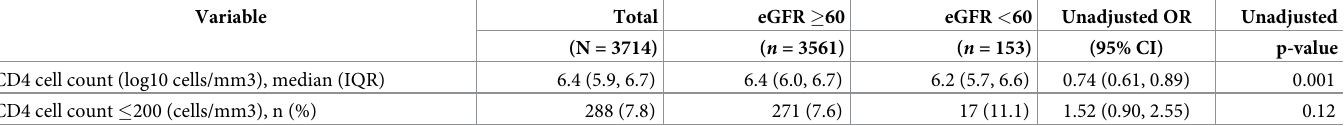
medications, emtricitabine/tenofovir was the most commonly prescribed (45%). The most common multiclass single tablet regimens were efavirenz/ emtricitabine /tenofovir (17%), elvi- tegravir/cobicistat/ emtricitabine/tenofovir (15%) and abacavir/ dolutegravir/lamivudine (14%). Regarding protease inhibitors, ritonavir (36%) and darunavir (26%) were frequently prescribed. Dolutegravir (15%) was the most commonly-used medication among the integrase inhibitors. In 2251 patients who were treated with NRTI medications, 1883 (84%) were treated with tenofovir and 368 (16%) were treated with other NRTIs. Subgroup analysis of the absolute change of eGFR over time in patients treated with NRTI medications indicated that compared with patients treated with other NRTIs, patients treated with tenofovir (TDF) had a statistically significant faster decline of eGFR per year with a median percent change of -0.2% (IQR -0.32,